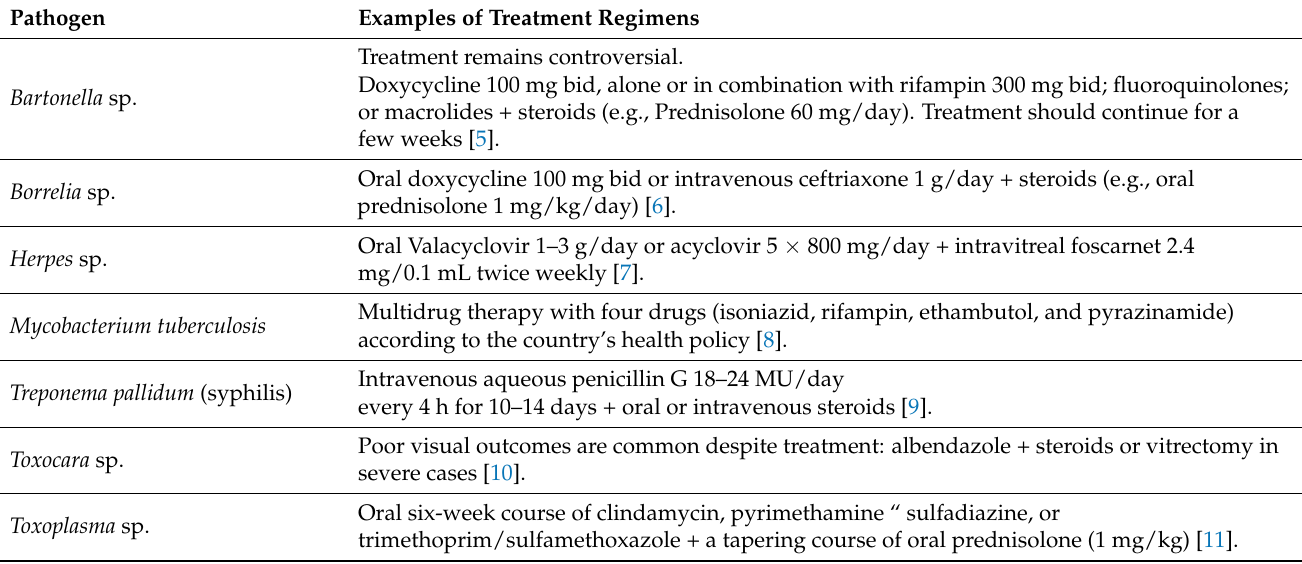
Table 1. Common infectious causes of uveitis and ME (in alphabetical order) along with treatment options. Pathogen Examples of Treatment Regimens